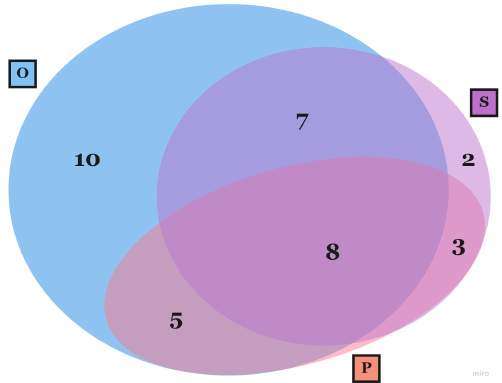
Figure 1. Venn Diagram representing the number of selected articles that focus on a flight simu- lation task (ST articles), using: Objective (O), Self (S), Performance (P) assessment approaches or their combinations.